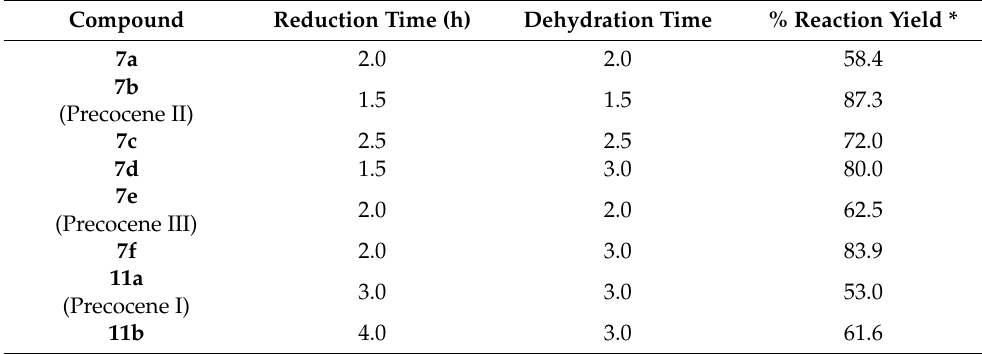
Table 4. Reaction times required for reduction and dehydration of corresponding compounds ( 6a – f ) and ( 11a – b ), as well as the % reaction